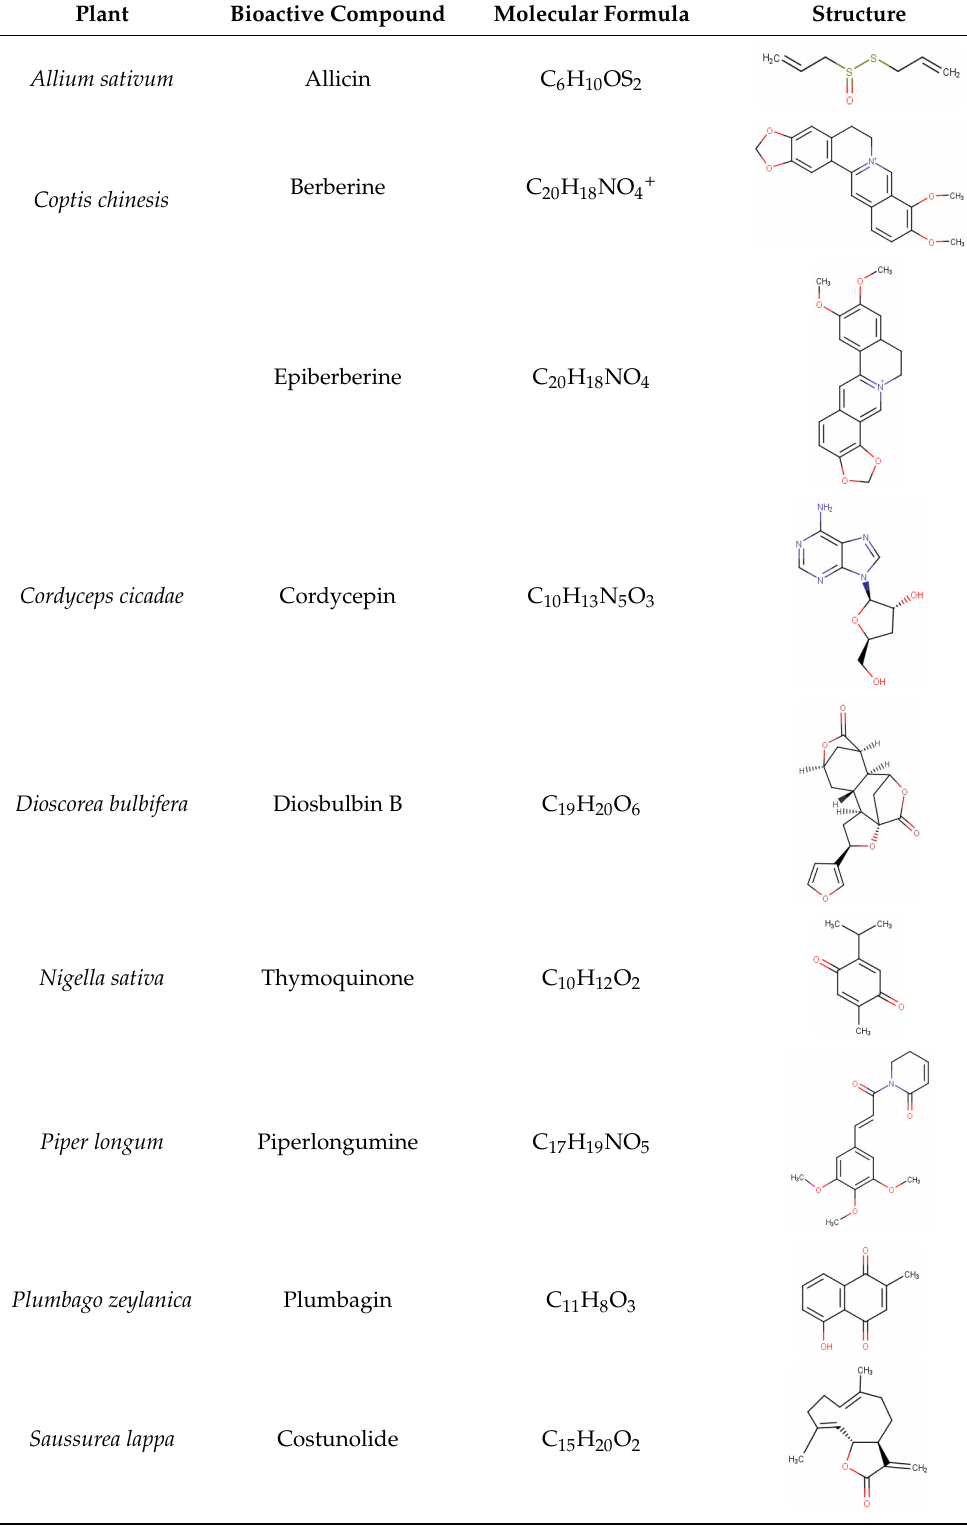
Table 2. The chemical structures of the single active components of the extracts characterized by the inhibitory activity against stomach cancer, described in the